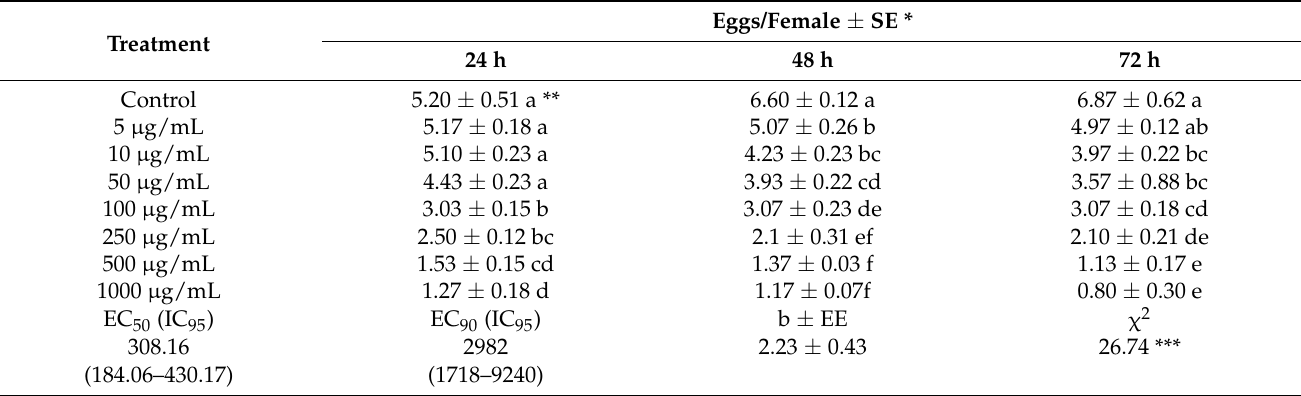
Table 2. Effect of ethanolic powdered extract of Magnolia tamulipana leaves on oviposition of Oligo- nychus punicae .